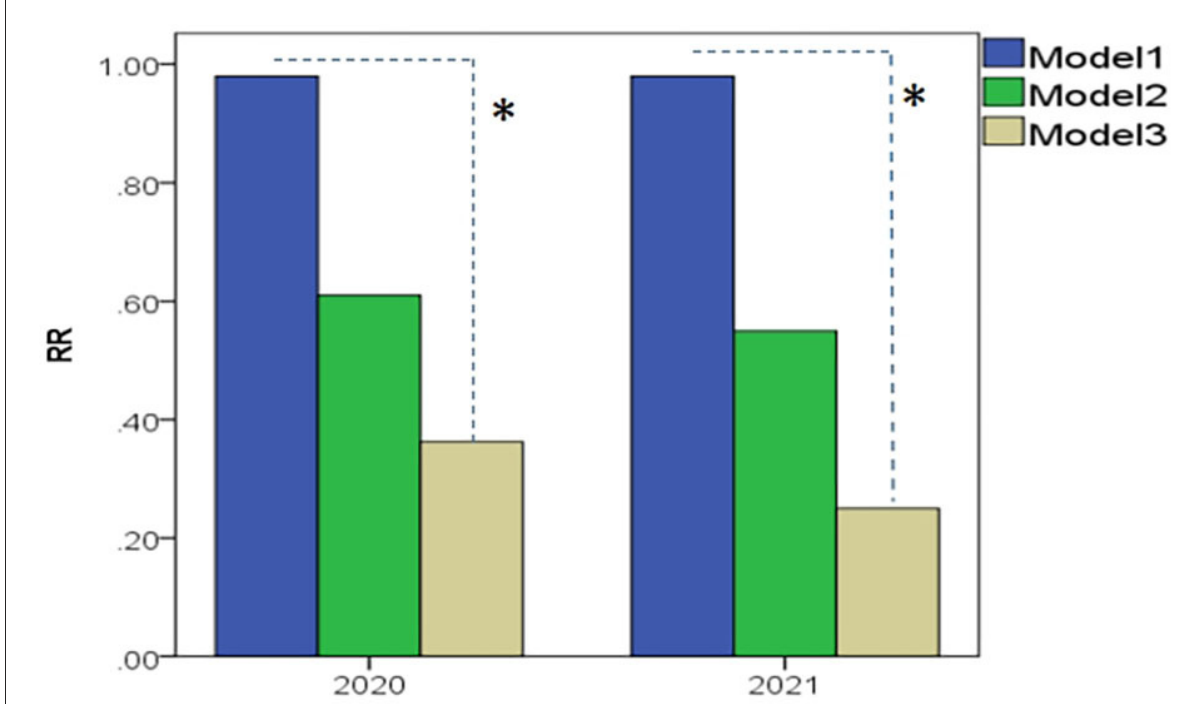
FIGURE2 Comparison results of RR among Model 1–3, as they, respectively, represented to ICMM quantitative model, the semi-quantitative comprehensive index model, and the model of occupational hazards classification at workplaces (industrial dust and chemical agents). Model 1: The ICMM quantitative model achieved the highest RR of 0.9 (0.6–1.0) in both 2020 and in 2021; Model 2: RR toward the semi-quantitative comprehensive index model went to 0.6 (0.4–0.8) in 2020 and 0.5 (0.4–0.6) in 2021, respectively; Model 3: the model of occupational hazards classification at workplaces left to the lowest of 0.3 (0.25–0.75) and 0.25. * P < 0.001 as significant differences of RR among models were compared.